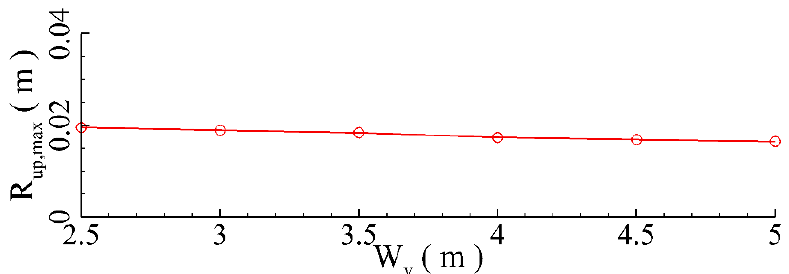
Figure 32. Wave energy dissipation rate under different vegetation lengths.